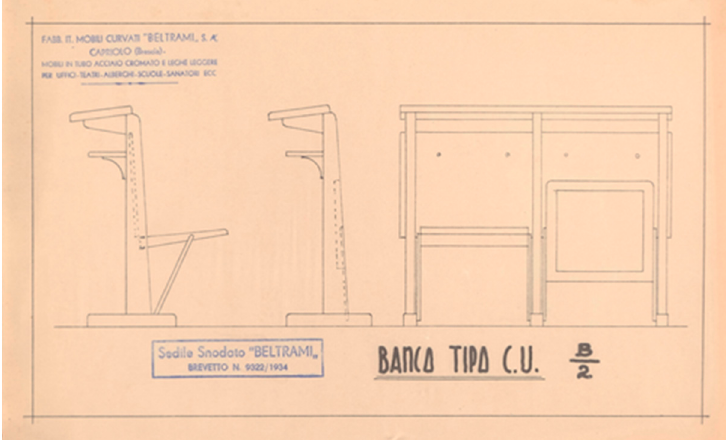
Figure 46. Technical drawing of articulated bench by Beltrami company. Patent 9322/1934. Image